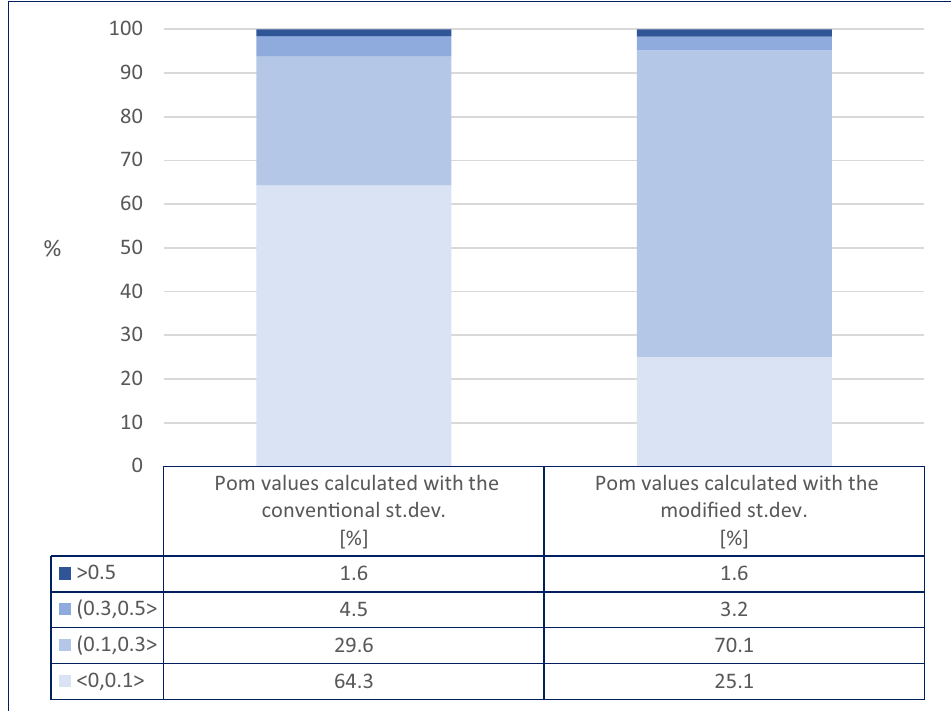
Figure 2. Comparison of P om values calculated with the conventional (stacked bar plot on the left) and modified (stacked bar plot on the right) st. dev in the case of measurements below the LOQ. The comparison is based on all chemical indicators in riverine water bodies classified in the good class in 2017. The range of P om values is divided into four intervals: < 0, 0.1 > , (0.1, 0.3 > , (0.3, 0.5 > , and (0.5, 1 > . For each interval, the percentage of indicators with P om belonging to this interval is